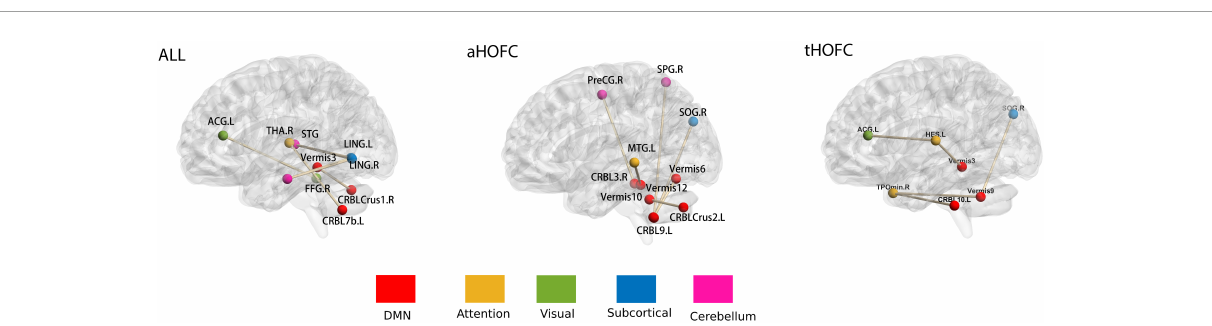
FIGURE3 The domain-adversarial training of neural networks.